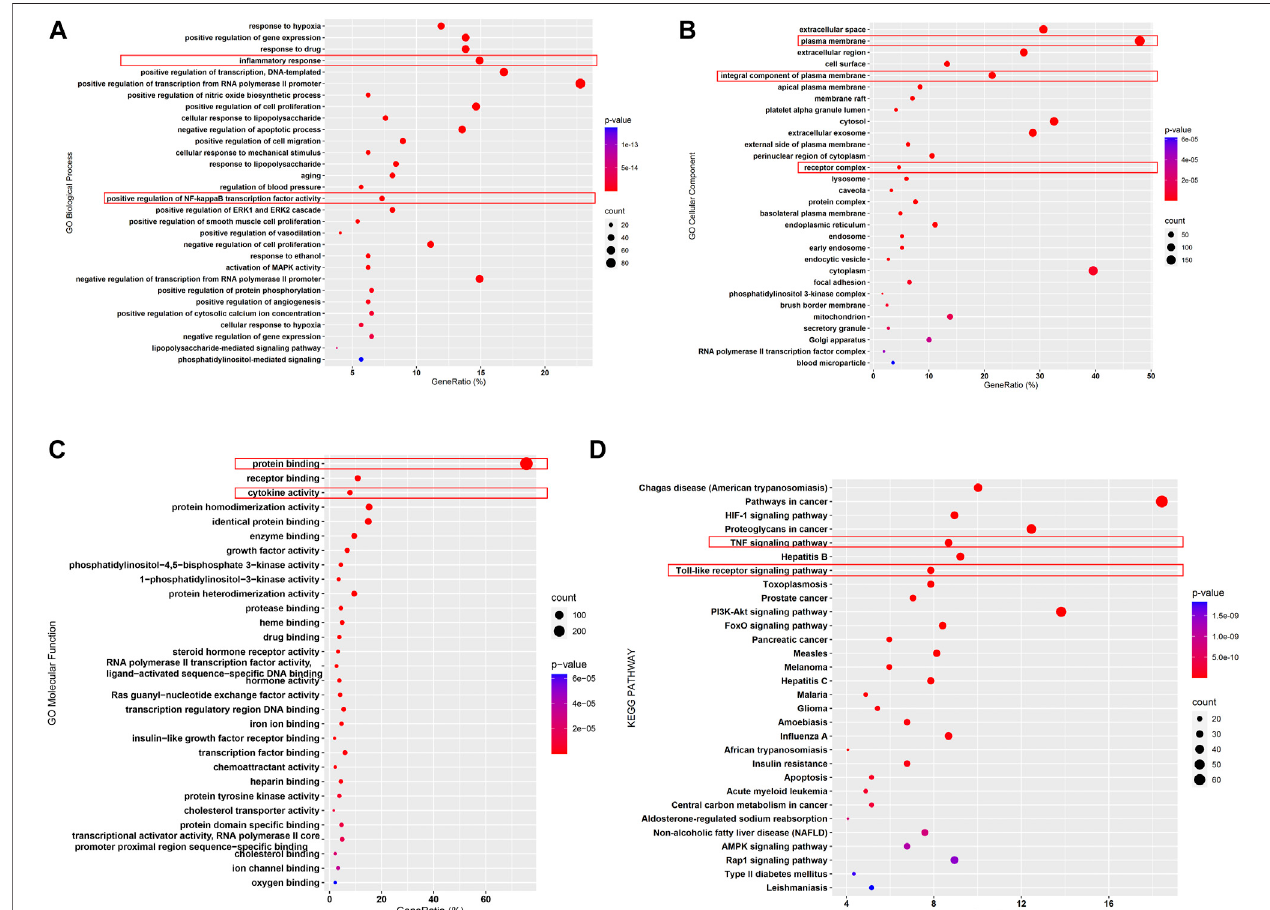
FIGURE2| EnrichmentanalysisofBYFcandidatetargetsagainstCKD.GOenrichmentanalysisrevealedtherelatedbiologicalprocess (A) ,molecularfunction (B) , and cellular component (C) ; KEGG pathway analysis revealed the related pathways (D) .